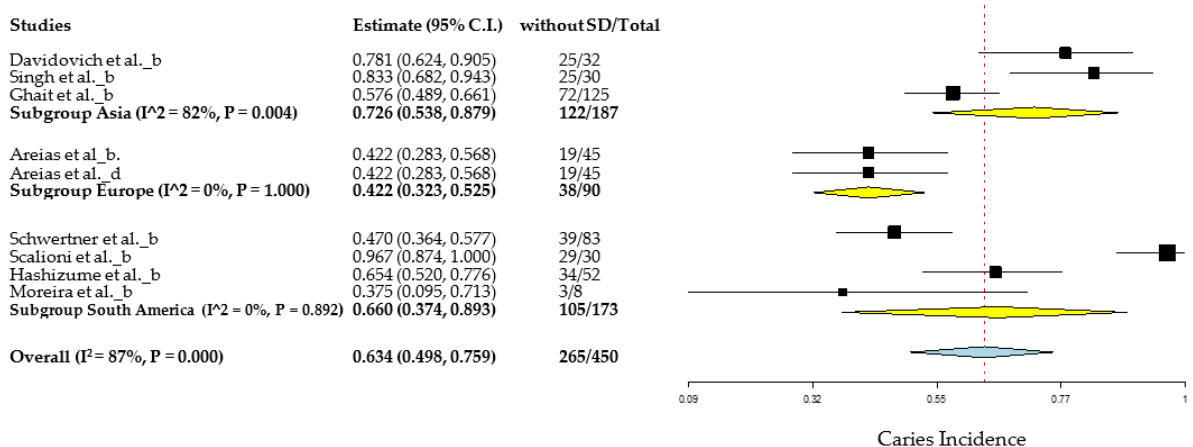
Figure A2. Geographic subgroup meta-analysis (Asia, Europe and South America) of caries incidence in control patients. Articles references (from top to bottom): Subgroup Asia [20,23,33], Subgroup Europe [24,26] and Subgroup America [21,28,29,35].